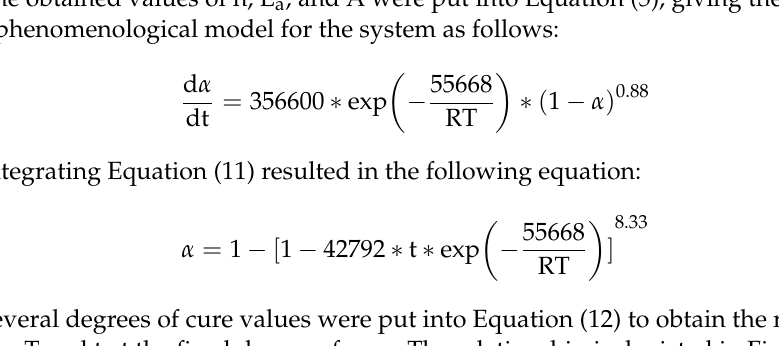
Figure 5. DSC curves of the H 6 XDI/BES system after incubation at 423 K for different times.